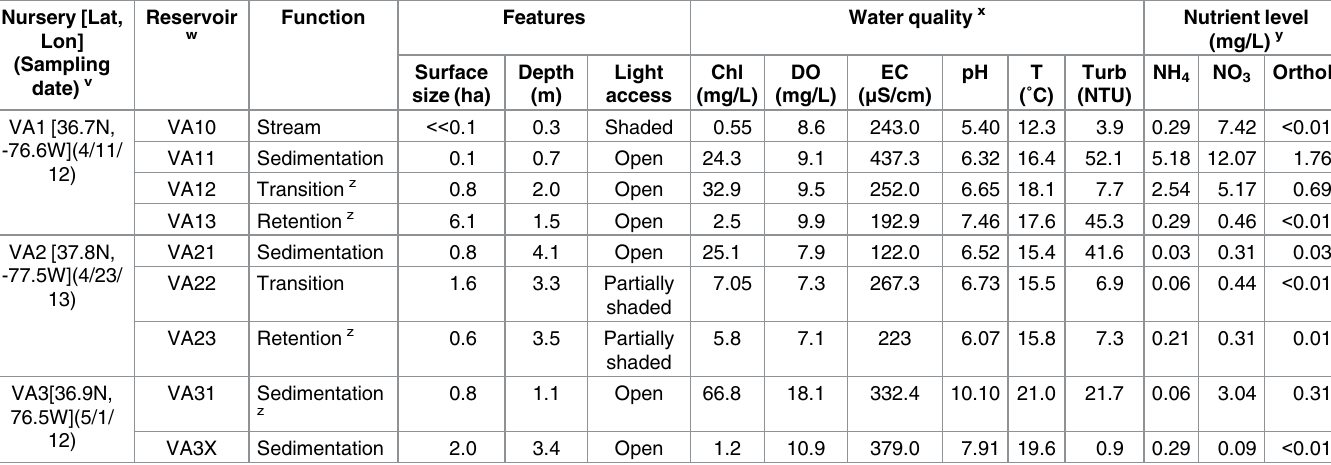
Table 1. Physical featuresand environmental variables of eight reservoirs and one adjacent stream surveyedin this study. Nursery [Lat, Lon] (Sampling date)